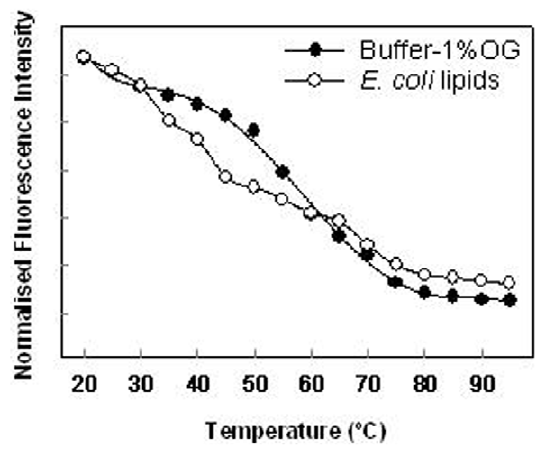
Figure 6. Fluorescence intensity at the maximum of the emission spectra as a function of temperature. The protein reconstituted in detergent micelles show one principal transitions in comparison with the protein reconstituted in lipid membranes where at least three different transitions can be observed. Fluorescence intensity values are normalized to the higher intensity value observed with the protein in micelles suspension at 20 u C.